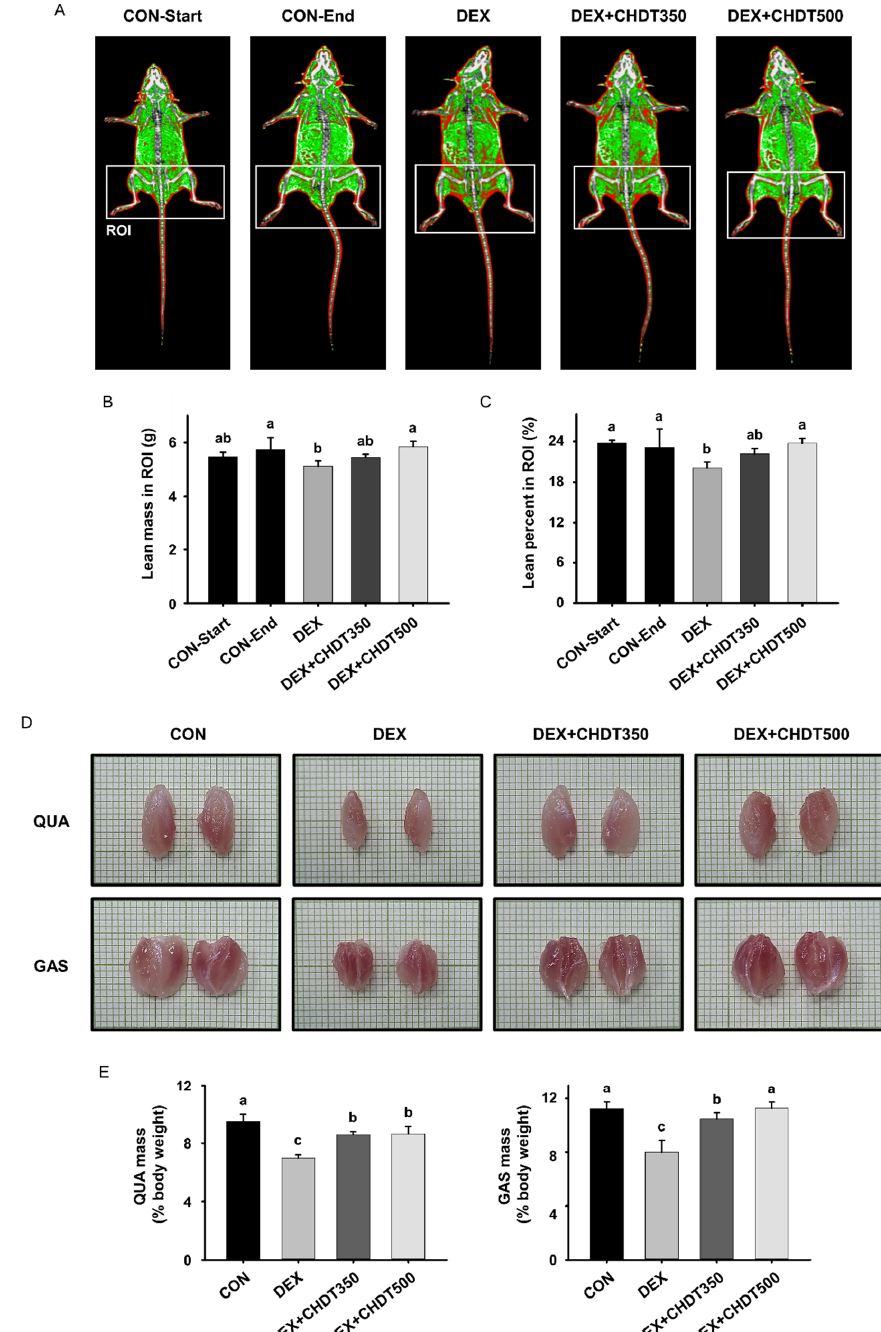
Figure 3. Effects of CHDT on the lean mass and muscle mass of mice with Dex-induced muscle atrophy. ( A ) Body composition images obtained using DXA analysis. Lean tissue is shown in green, fat in red, and bone in white. The lean mass of the mice was measured twice: before the start of the study and at the end of the period of administration (on day 30). ( B ) Lean mass and ( C ) lean percentage in the ROI, which surrounds the mouse hindlimbs. ( D ) At the end of the study, representative images of the quadriceps (QUA, top) and gastrocnemius (GAS, bottom) muscles were taken. The scale of one grid is 1 mm. ( E ) Masses of the QUA (left) and GAS (right) muscles, normalized to the most recently measured body mass. Different letters indicate statistically significant differences; p < 0.05, a > b >